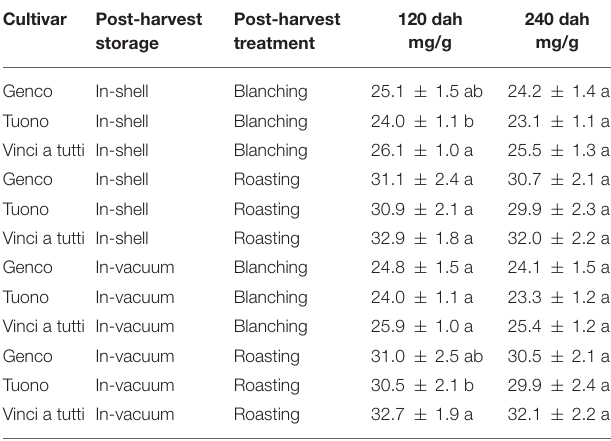
TABLE 3 | Polyphenols in the seed skin of three Italian almond cultivars at 120 and 240 dah during in-shell and vacuum storage.